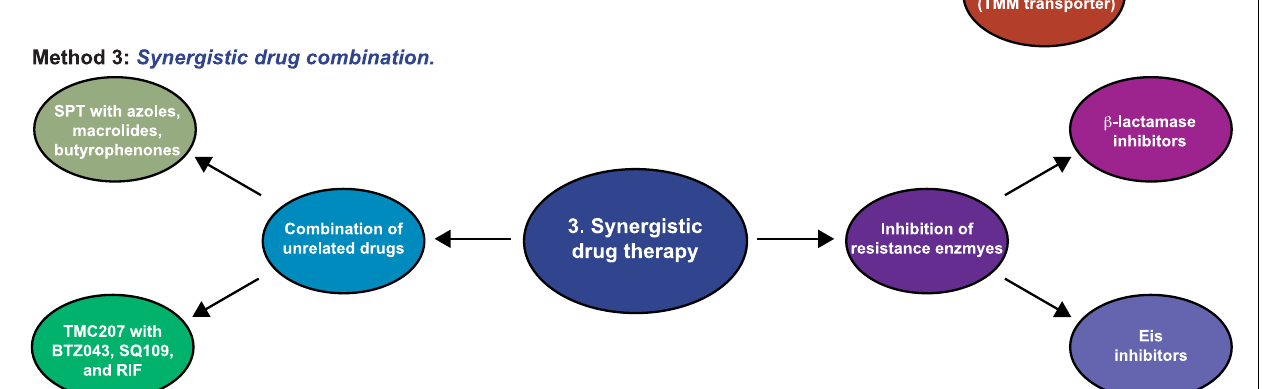
Frontiers in Microbiology | Antimicrobials, Resistance and